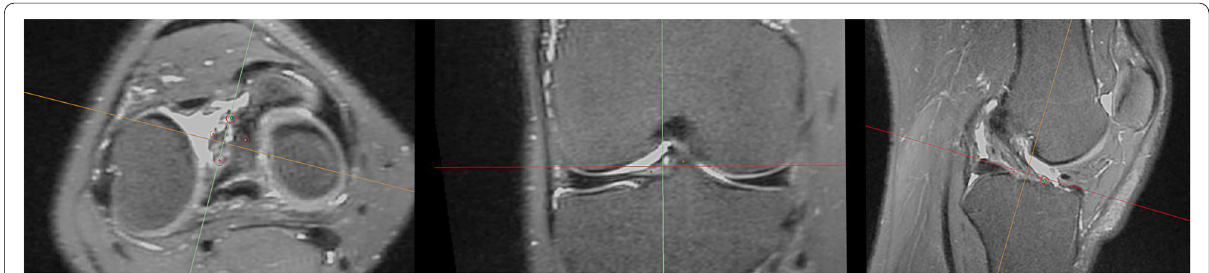
Fig. 2 Identification tibial ACL footprint in Materialise Mimics